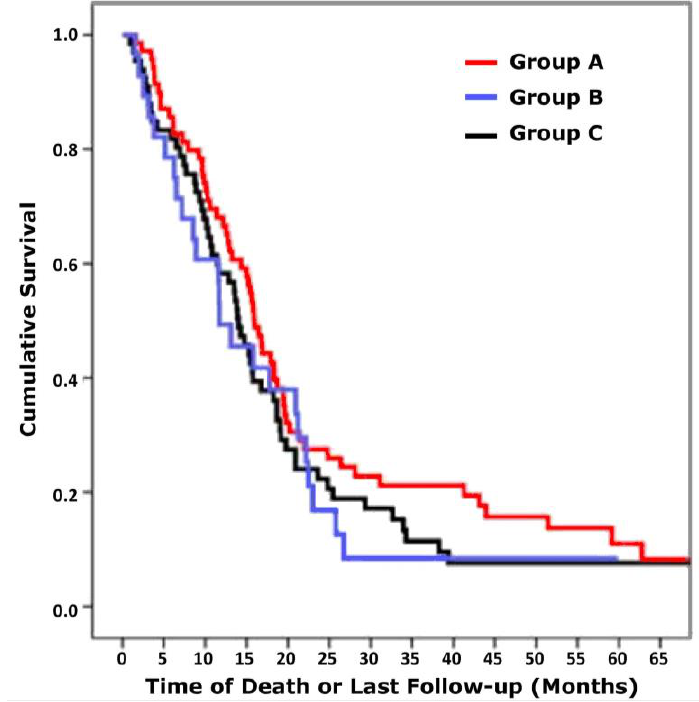
Figure 4. Kaplan–Maier Survival Plots for Different Groups. Group A: Evidence of ependymal enhancement on MRI. Group B: No evidence of ependymal enhancement on MRI. Group C: Ependymal enhancement on MRI